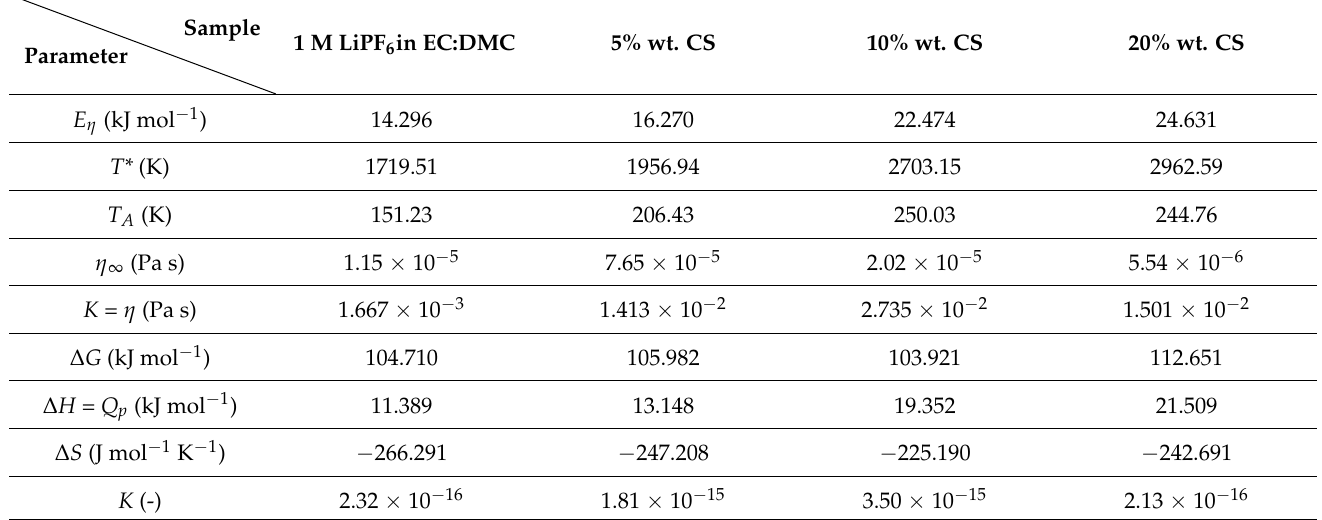
Table 2. Average kinetic and thermodynamic parameters of pure electrolyte and with CS